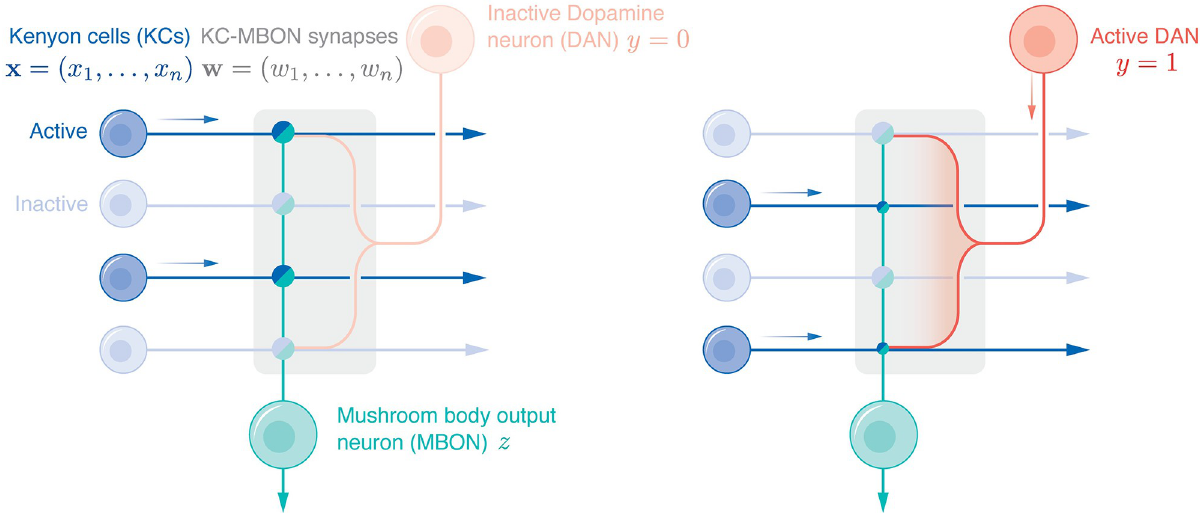
Fig 1. A simplified schematic of a mushroom body compartment. In both the left and right panels, the mushroom body compartment, indicated by the shaded box, is innervated by the axons of multiple KCs, the dendrites from one MBON and the axon terminals of one DAN. The bi-colored circles at the intersections of the KC axons and the MBON dendrites denote the KC-MBON synapses. Faintly shaded cell bodies indicate inactive neurons and boldly shaded cell bodies indicate active neurons. In the left panel, the DAN is inactive. In the right panel, the DAN is active and co-activation of the KCs and the DAN weakens the associated KC-MBON synapses (as illustrated by the smaller